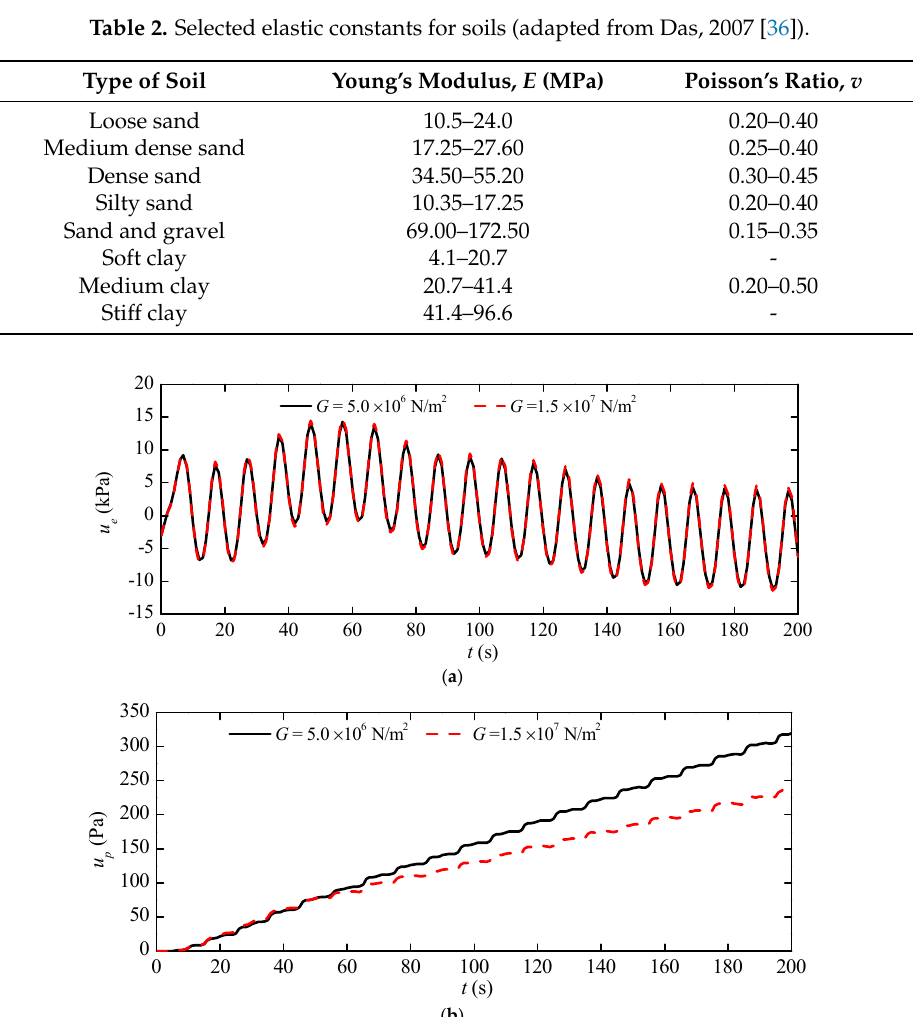
Figure 5 . Variations of ( a ) oscillatory pore pressure, 𝑢 (cid:3032) and ( b ) residual pore pressure, 𝑢 (cid:3043) at a specific Figure 6. Variations of ( a ) oscillatory pore pressure, u e and ( b ) residual pore pressure, u p at a specific point under the different shear modulus. point under the different shear